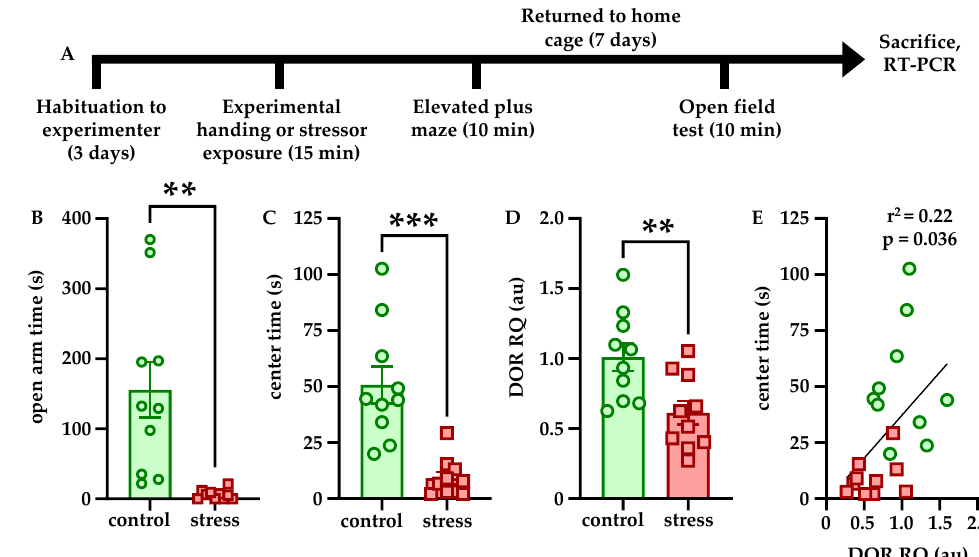
Figure 1. Stress increases anxiety-like behavior and decreases LC DOR expression. The experi- mental timeline is shown in ( A ). Rats were habituated to handling by the experimenter for 3 days but were naïve to the behavioral apparatus when testing began. Fifteen minutes of combined restraint and predator odor exposure increased anxiety-like behavior in the EPM immediately ( B ) and in the OFT one week later ( C ). Stressor exposure was also associated with decreased DOR expression ( D ) which significantly correlated with center time in the OFT ( E ). ** p < 0.01; *** p <